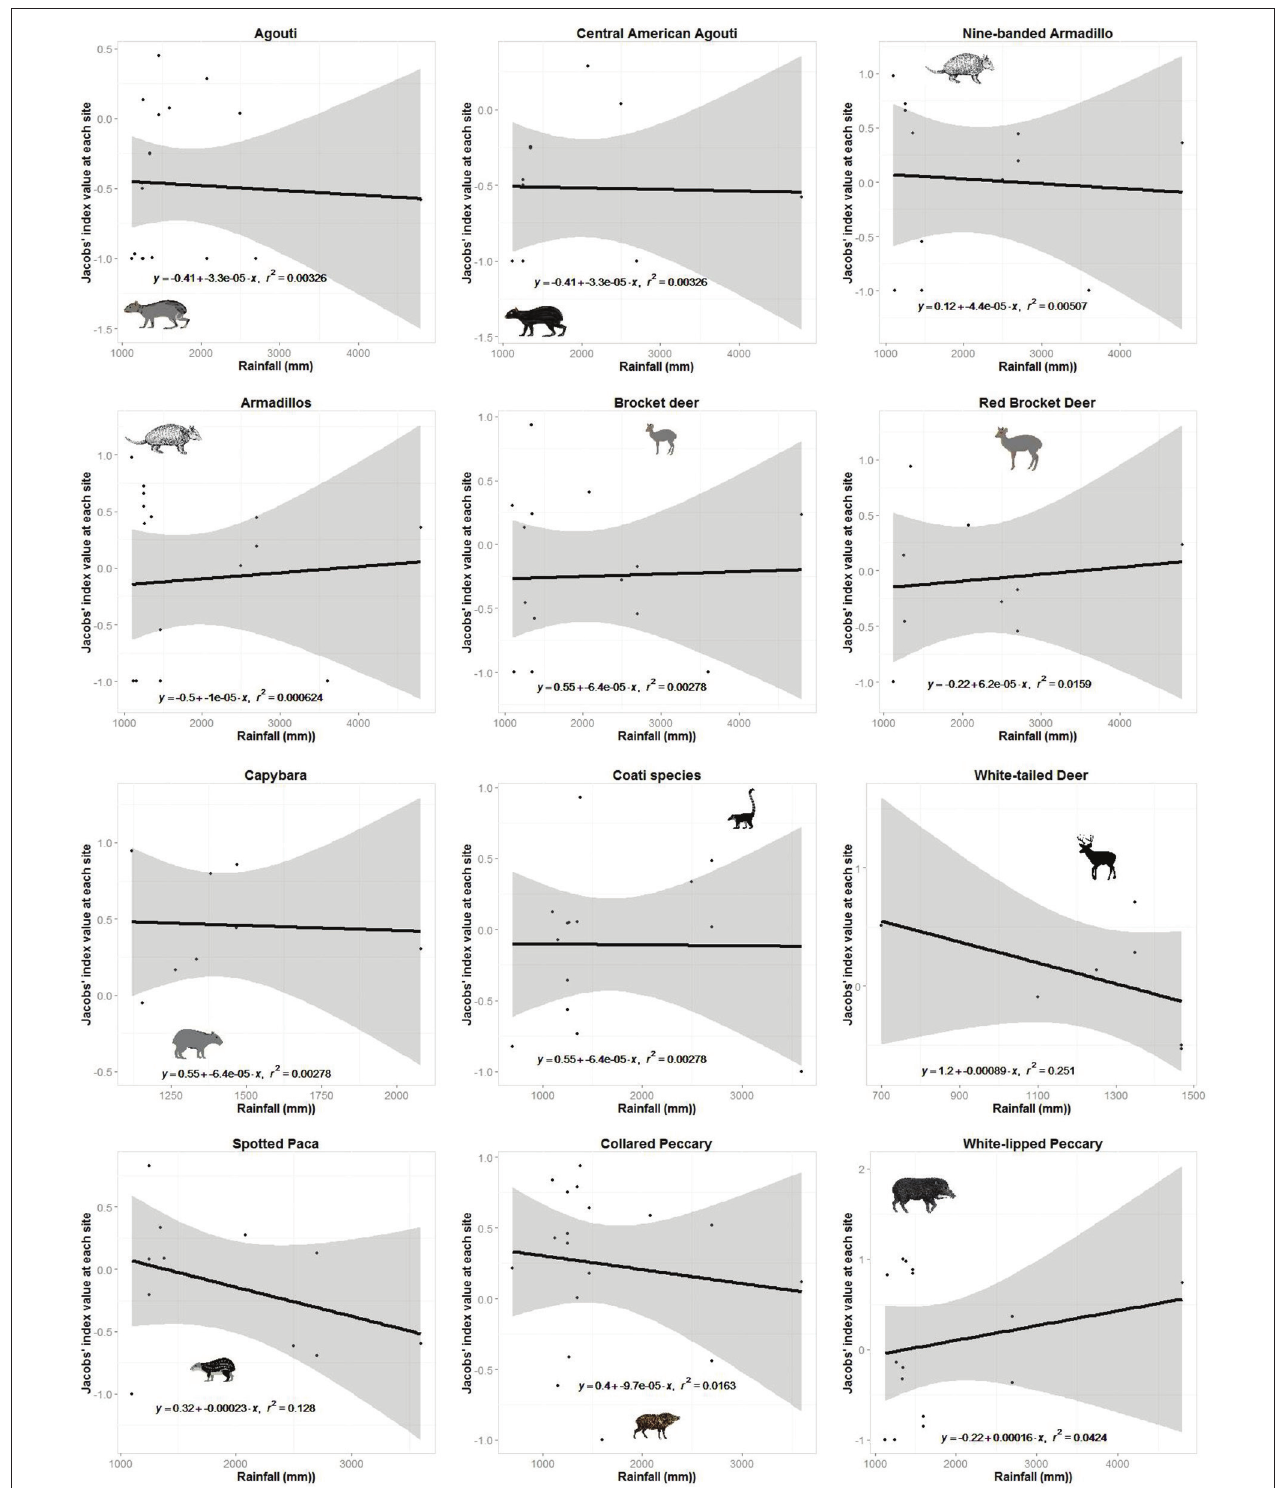
FIGURE 4 | Plots of the relationship between prey preference of jaguar prey species or taxonomic groups with more than six site records and the mean annual rainfall at each site.